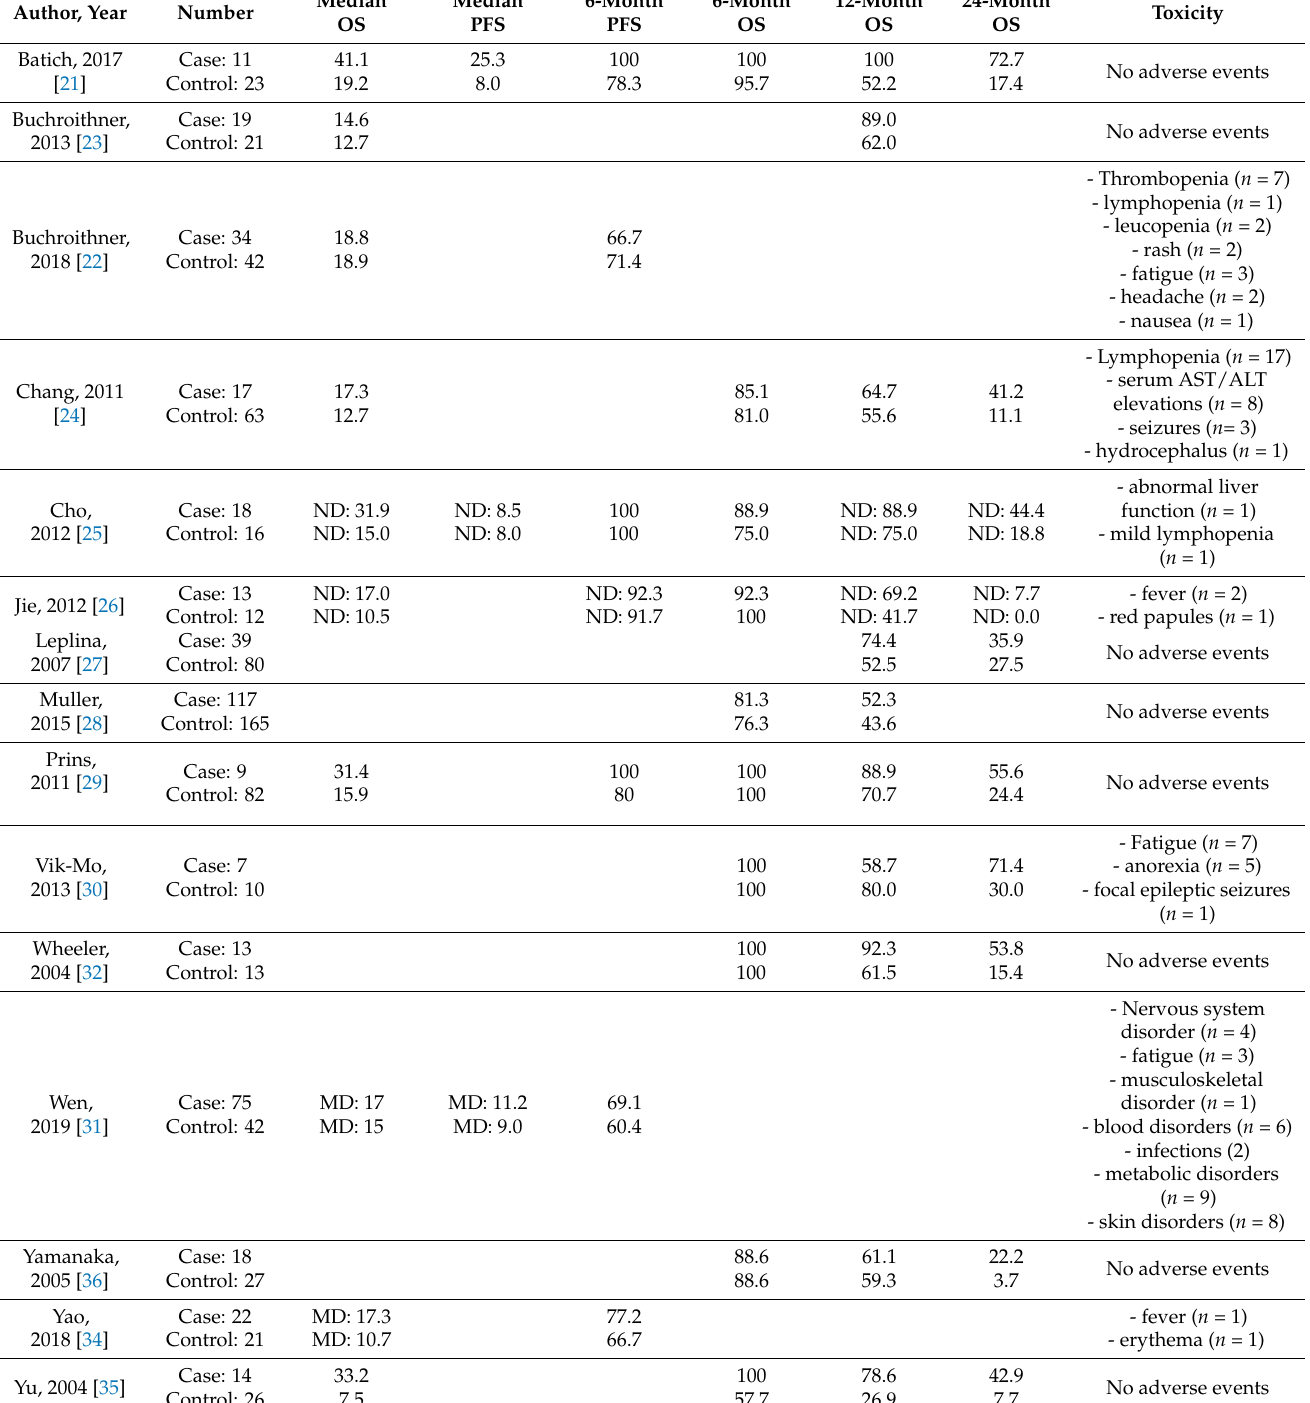
Table 2. The outcome of the dendritic cell vaccination